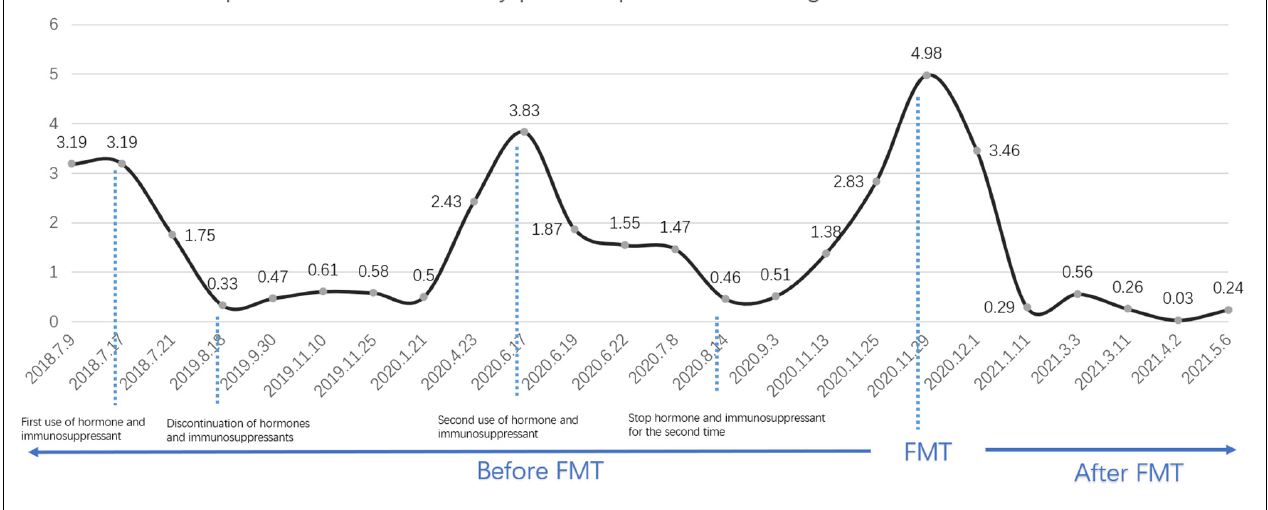
FIGURE 1 | Patient’s 24-h urine protein quantitative changes since the initial